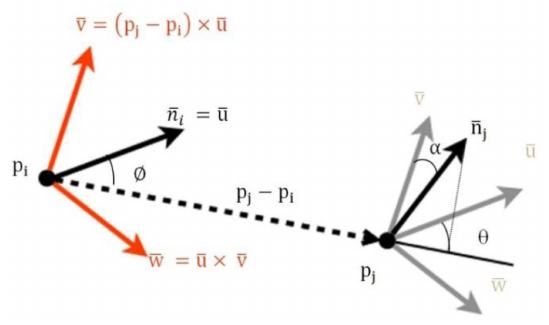
Figure 6. Geometric variation between two points based on the framework of Darboux